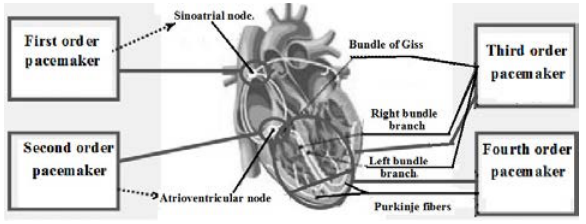
Fig. 4. Illustration of the location of pacemakers of various orders in the heart